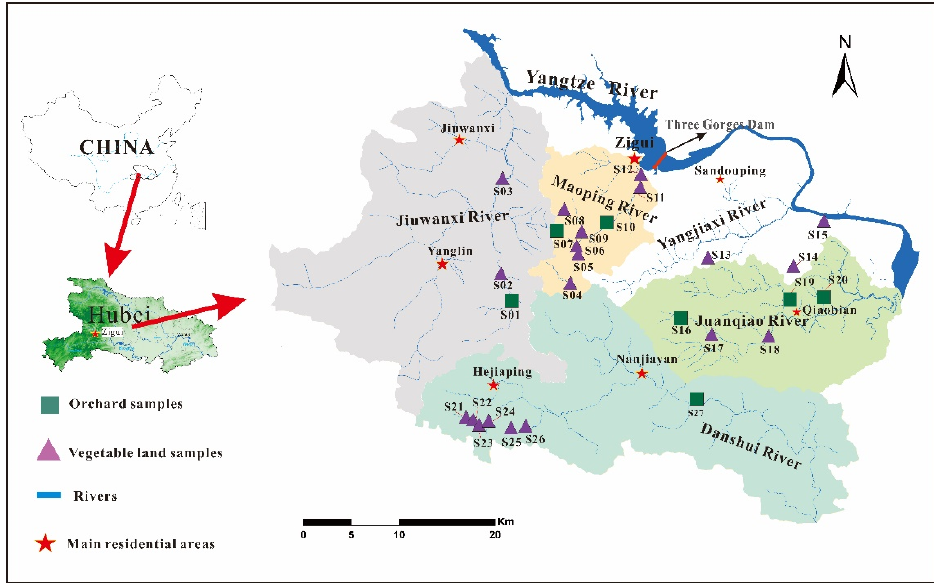
Figure 1. Location of the karst study area near Three Gorges Dam, China and the soil sampling sites.